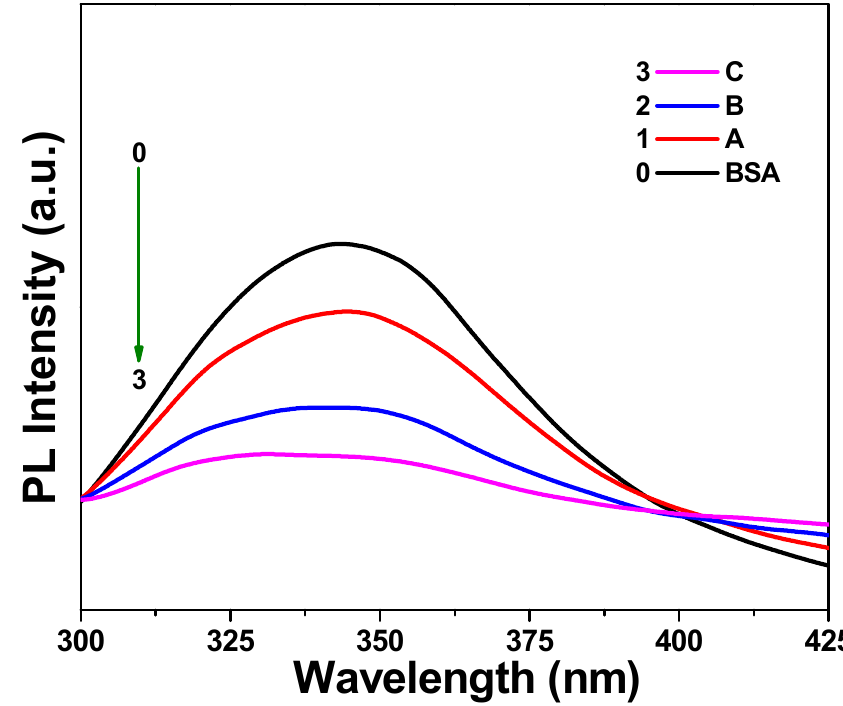
Figure 5. Photoluminescence (PL) spectra of aqueous BSA (10 − 6 M) solutions in the presence of varying IB amounts: 100 μ g ( A ), 500 μ g ( B ), and 1,000 μ g ( C ) in 10 mL of aqueous BSA solution.